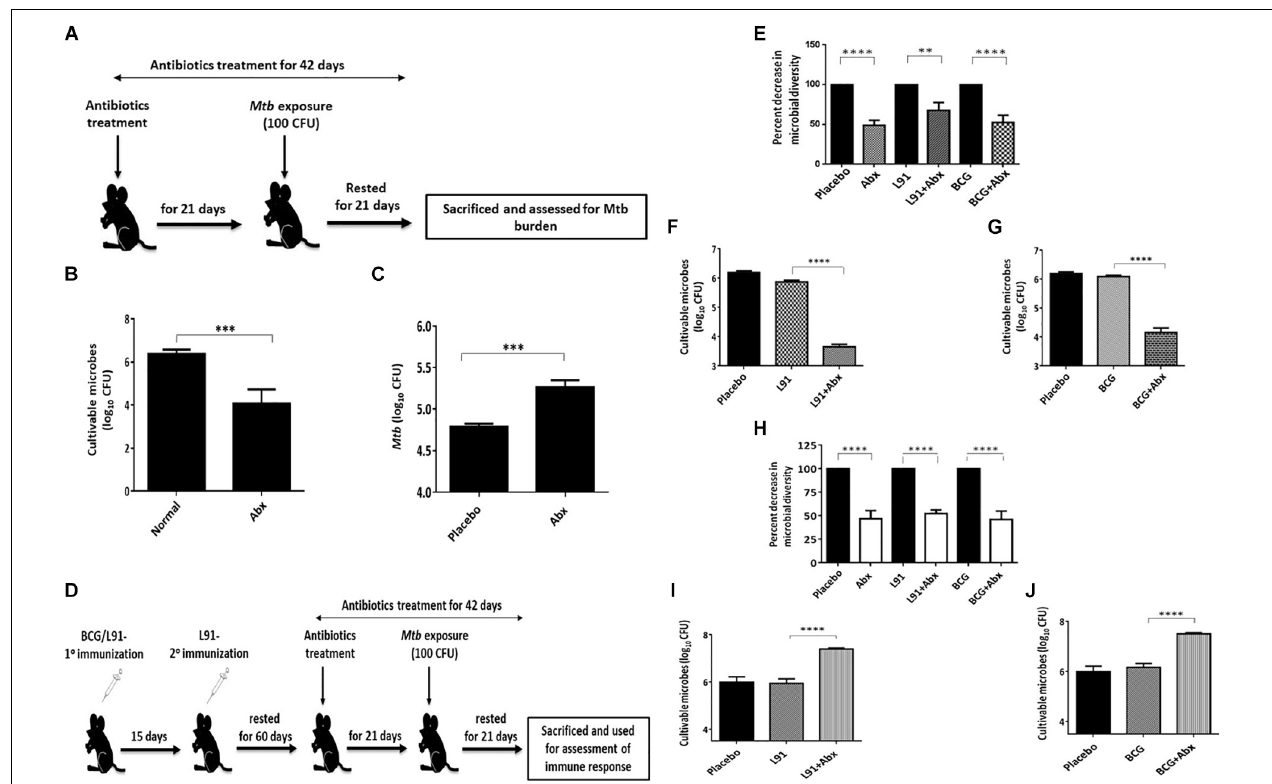
FIGURE 1 | Abx distorted the gut microbial composition. (A) Schematic representation of a mouse model to evaluate the influence of Abx on gut microbiota. Mice were administered Abx for 21 days. (B) Subsequently, 21 days post Abx treatment, frequency of cultivable microbes was monitored in the fecal samples by CFU assay. The control group was administered PBS only (Normal). Later, the animals were Mtb challenged with 100 CFUs deposition in the lungs. (C) The Mtb burden in the lungs was monitored after 21 days. The control group was administered PBS (Placebo). (D) Mice were injected with BCG (1 × 10 6 CFU) or L91 (20 nmol) vaccine candidates and then rested for 60 days. Subsequently, mice were administered Abx for 42 days. After the initial Abx treatment for 21 days, the animals were challenged with Mtb . Cultivable microbes and microbial diversity were monitored in the fecal samples on day 5 (E–G) ; day 42 (H–J) of Abx treatment by CFU assay on different agar media. Data shown as mean ± SEM are representative of 2 independent experiments ( n = 3–4 animals/group). ** p < 0.01, *** p < 0.01, and **** p <